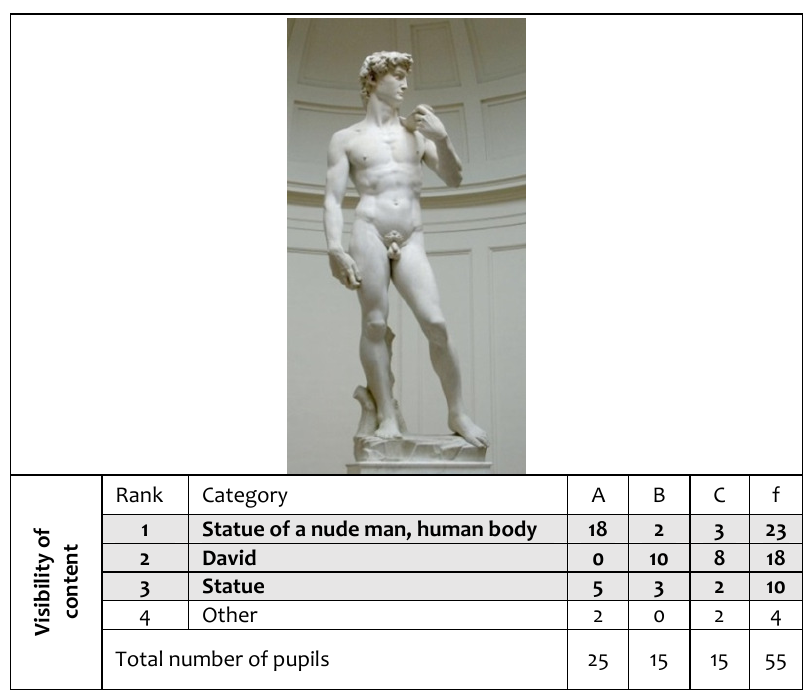
Table 4: Ranking order of the categories of answers regarding the visibility of the content of the first example (Michelangelo: David, 1501-1504).